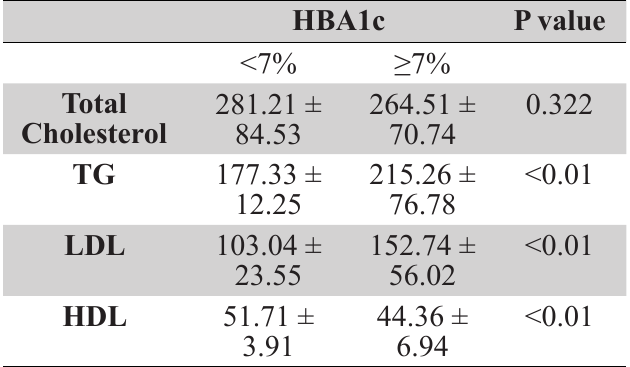
Table 4. Mean of lipid profiles among good and